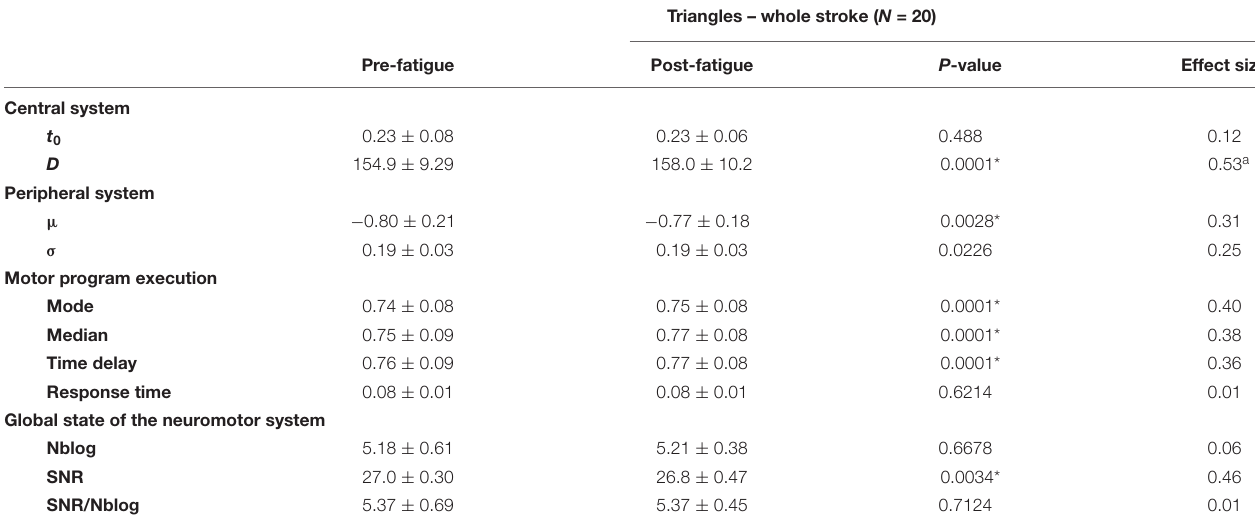
TABLE 3 | Parameters evolution in the triangles, after a shoulder fatigue in external